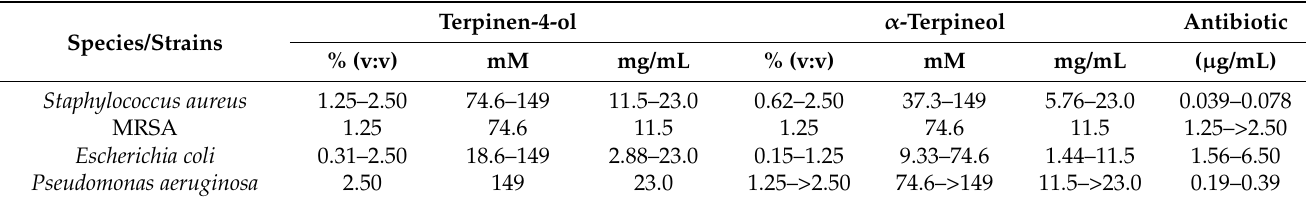
Table 1 summarizes results of MICs for terpinen-4-ol and α -terpineol in % (v:v), mM and mg/mL. As percentage as a concentration unit is commonly used for essential oils and their compounds, this unit is used in the rest of the article [7,15,17,18,37]. Table 1. Minimum inhibitory concentration (MIC) of α -terpineol and terpinen-4-ol. MIC assays were performed on four Gram-positive and Gram-negative species. The range of concentrations tested is 0.00499–2.50% (v:v). MRSA: methicillin-resistant Staphylococcus aureus . Antibiotics used as controls are ampicillin for Staphylococcus aureus and MRSA, amoxicillin for Escherichia coli , and gen- tamycin for Pseudomonas aeruginosa ( n = 3).